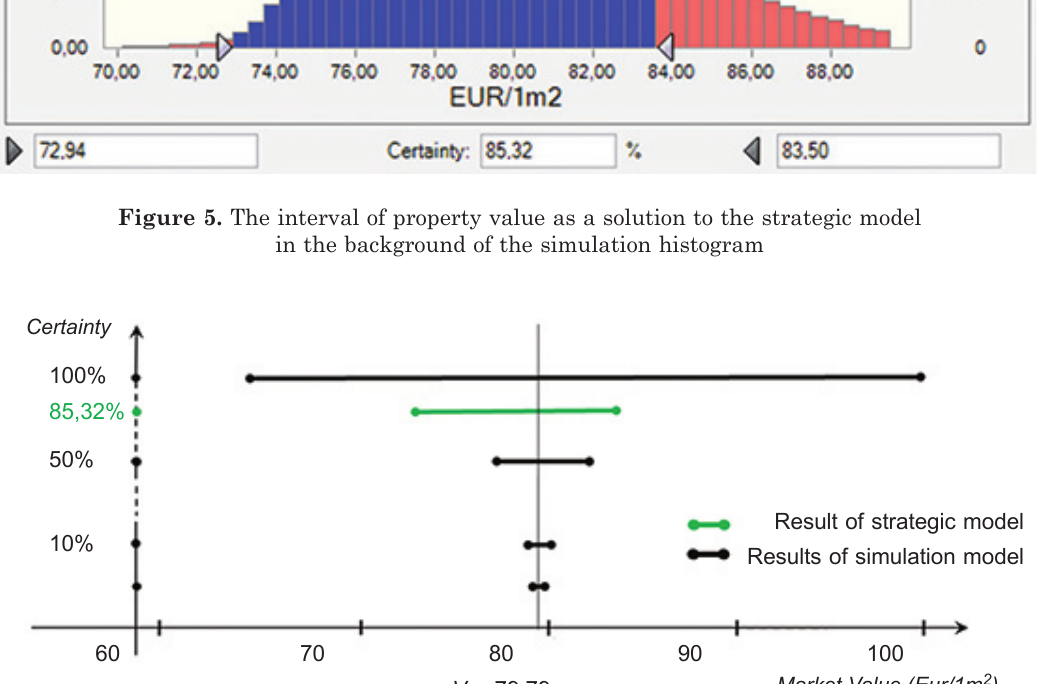
Market Value (Eur/1m 2 ) V =